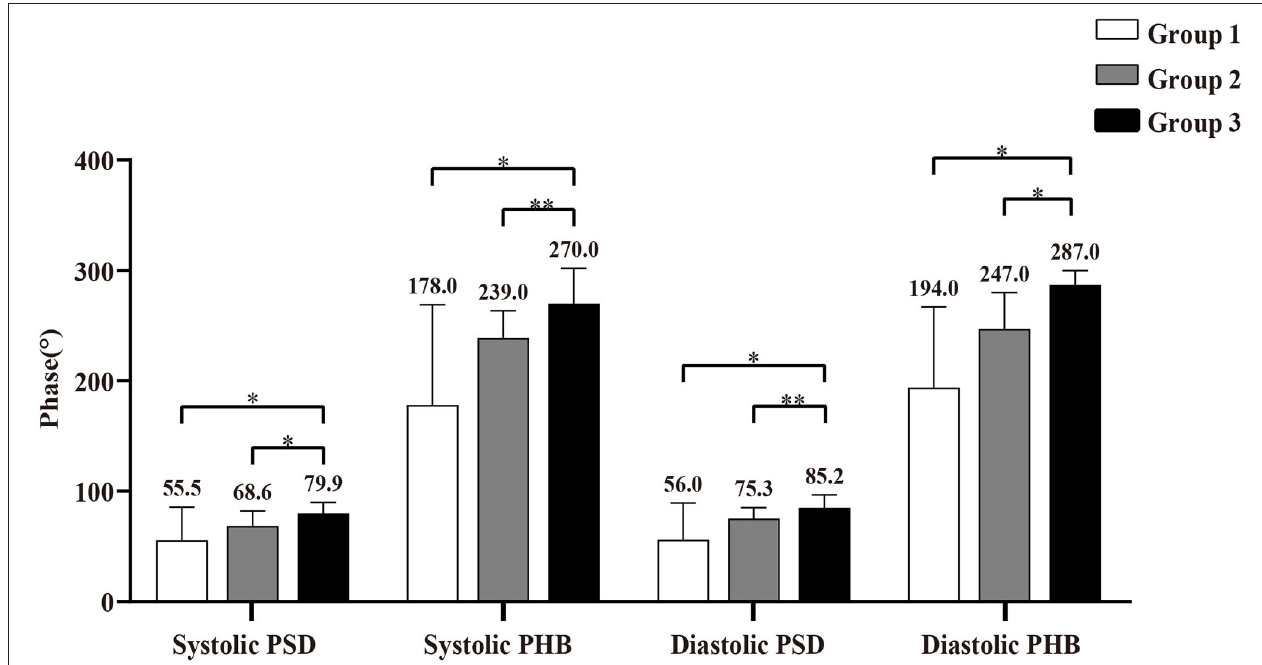
FIGURE 2 | Comparison of left ventricular mechanical dyssynchrony (LVMD) parameters in Group 1 (patients with viable myocardium only), Group 2 (patients with more viable myocardium than scar), and Group 3 (patients with more scar than viable myocardium). * Indicates P < 0.05, and ** indicates P < 0.01. PSD, phase standard deviation; PHB, phase histogram